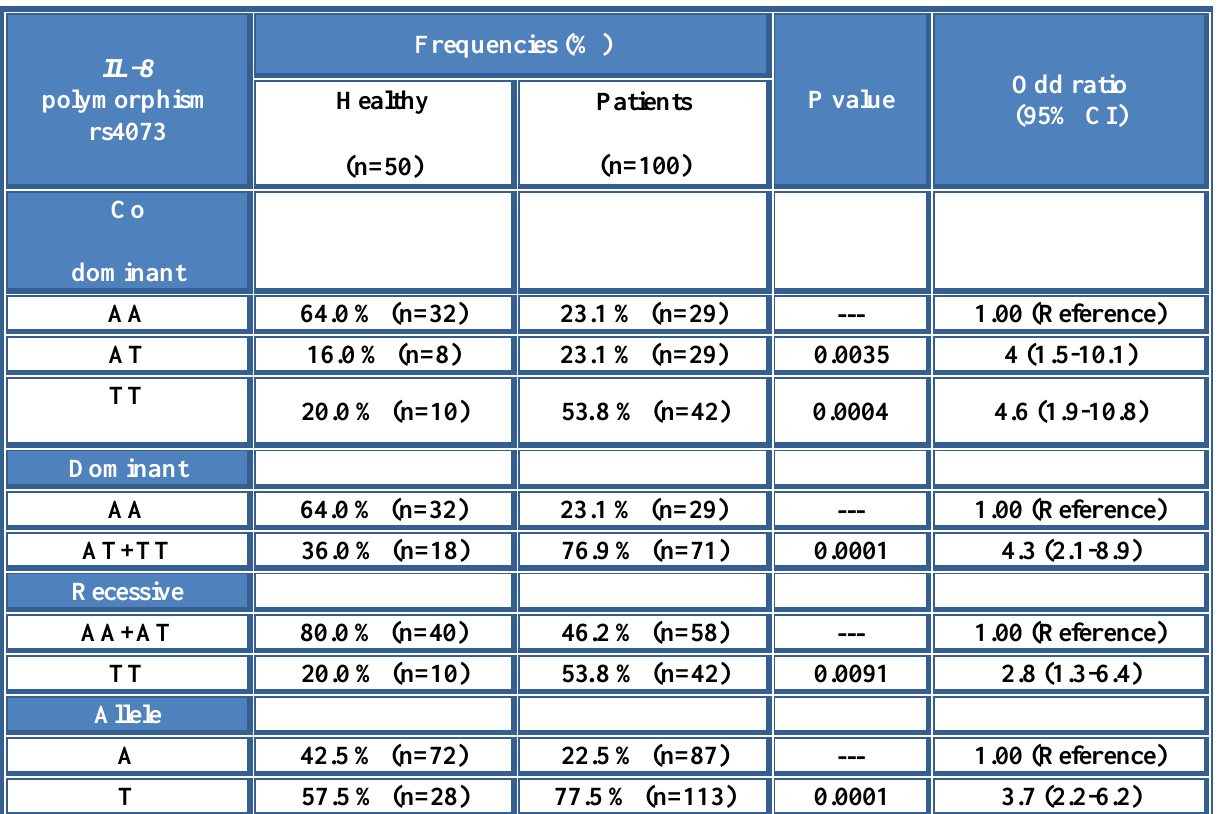
Table 4 : Comparison of the Genotype and Allele Frequencies of IL8 gene poly morphism (rs4073) between patients’ and the Healthy